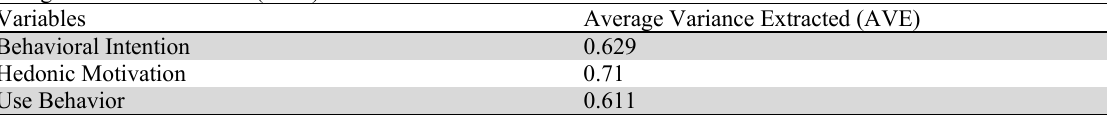
Average Variance Extracted (AVE) Variables